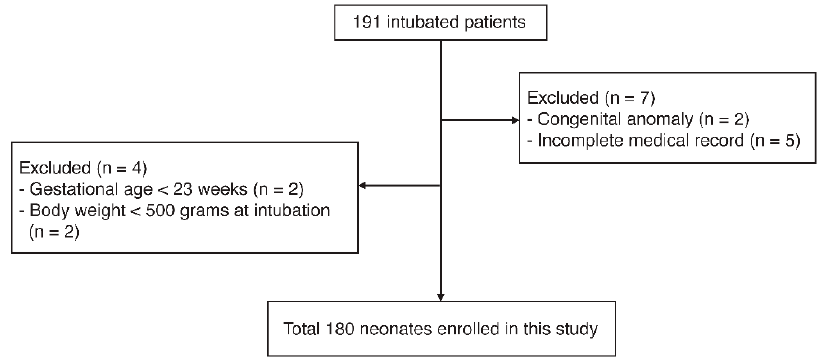
Figure 2. Study flowchart. Table 2. Baseline characteristics of the intubated neonates.